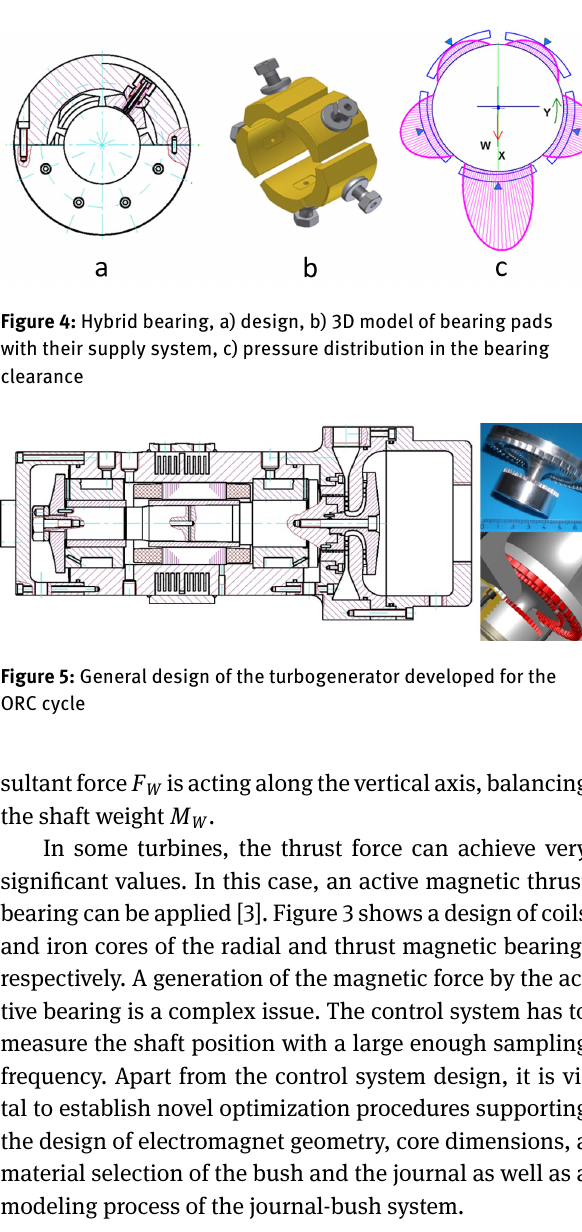
Figure 3: Active magnetic radial and thrust bearing actuators